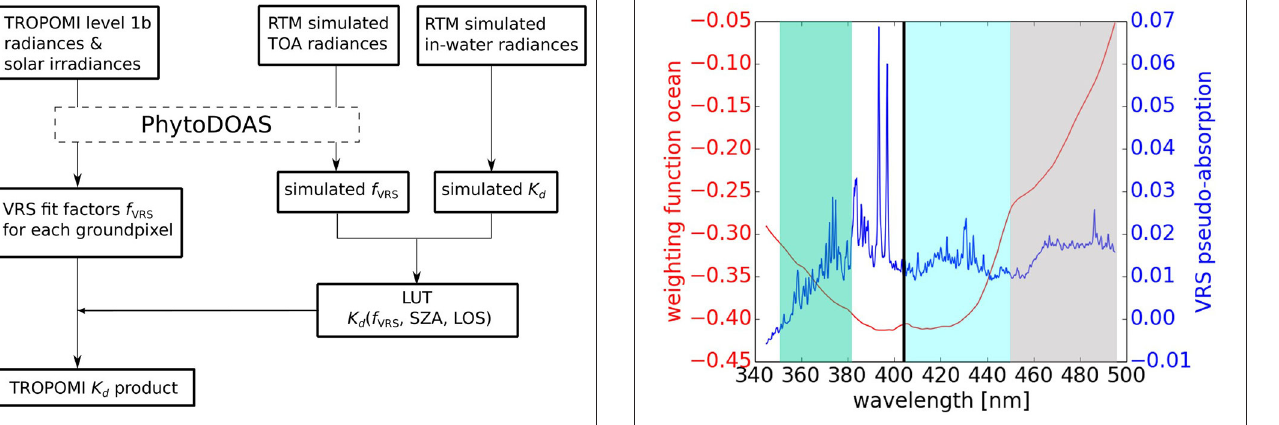
cross sections as function of wavelength. Colored areas indicate UV (green), short-blue (blue) and blue (gray) DOAS fit windows. The thick black line marks the end/start of band